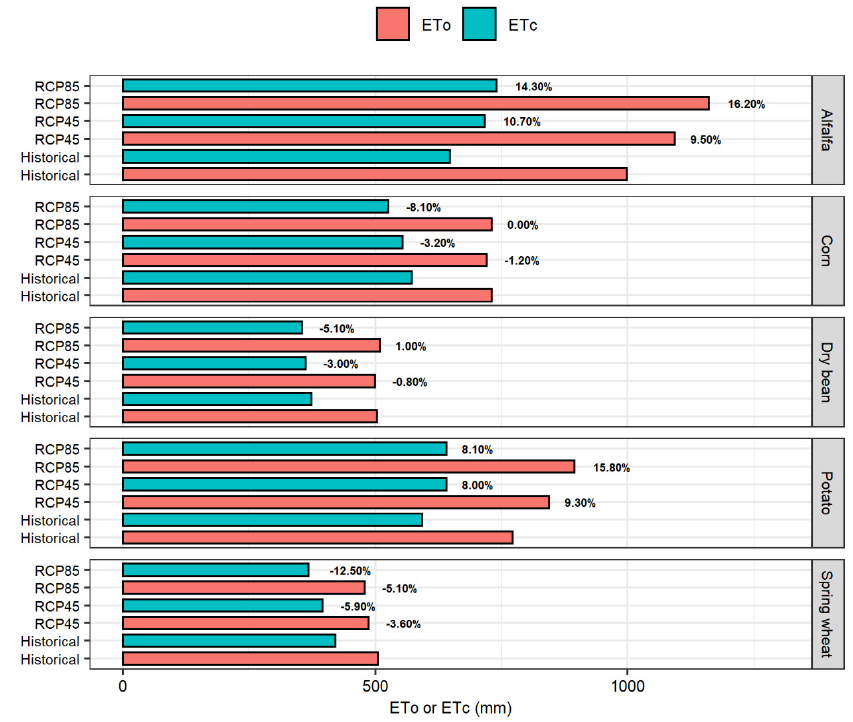
Figure 6. Reference crop evapotranspiration (ETo) and crop evapotranspiration (ETc) totals for the growing season of five crops during the historical and 2090s periods. Results are for a fixed planting date under transient CO 2 .